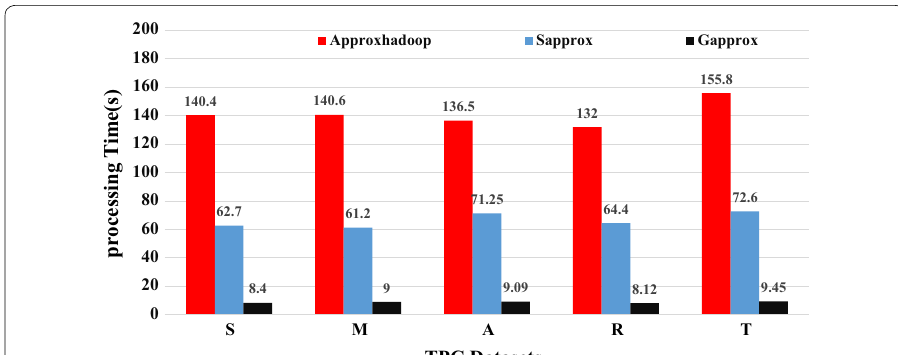
Fig. 11 Processing time for sampling (TPC datasets)